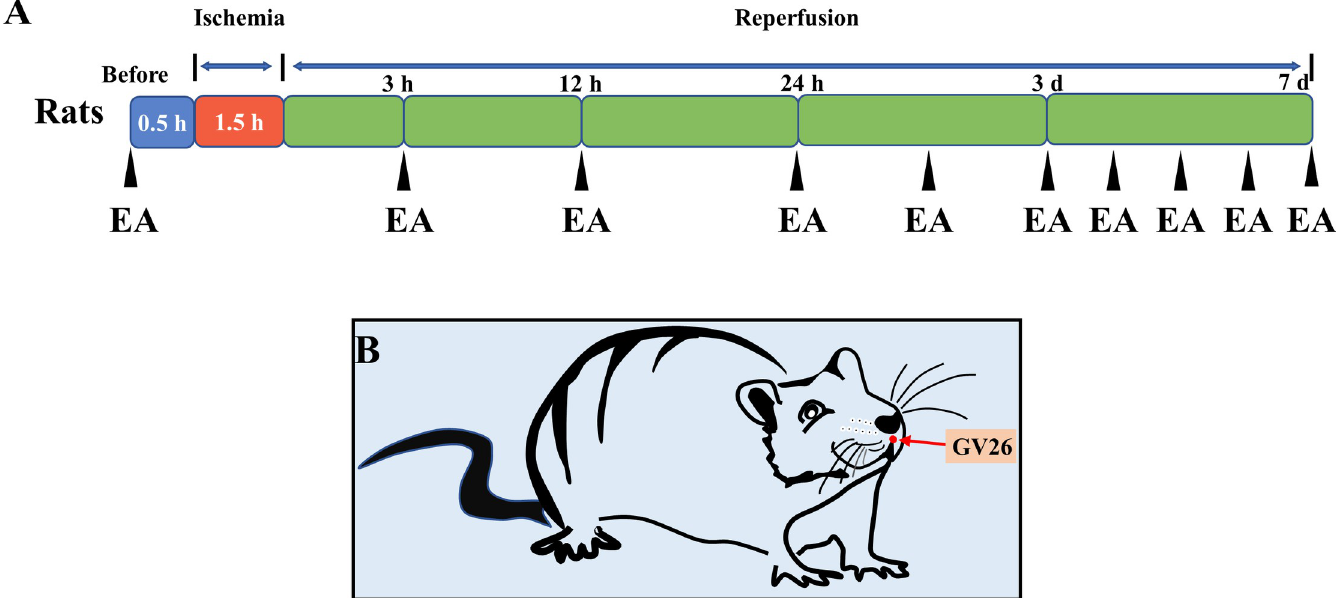
Fig 1. Experimental scheme. (A) Neurological deficit scores, TTC staining, and follow-up experiments were performed on rats in each group at 3 h, 12 h, 24 h, 3 d, and 7 d after operation. Rats in the EA group were treated 30 min before surgery and 3 h, 12 h or 24 h after reperfusion. Thereafter, the EA group received EA at GV26 acupoint once a day. (B) Schematic diagram showing the GV26 acupoint location.